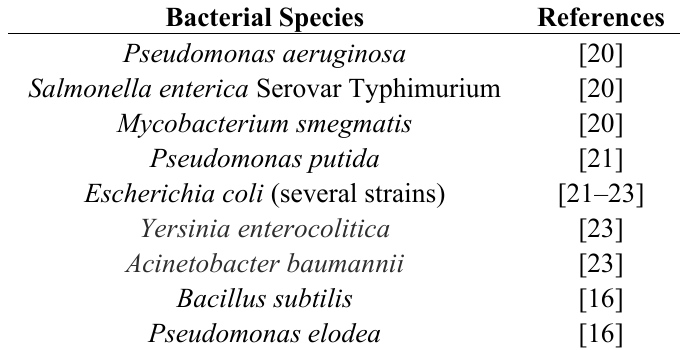
Table 1. Bacterial species in which clay-mediated transformation has been examined.